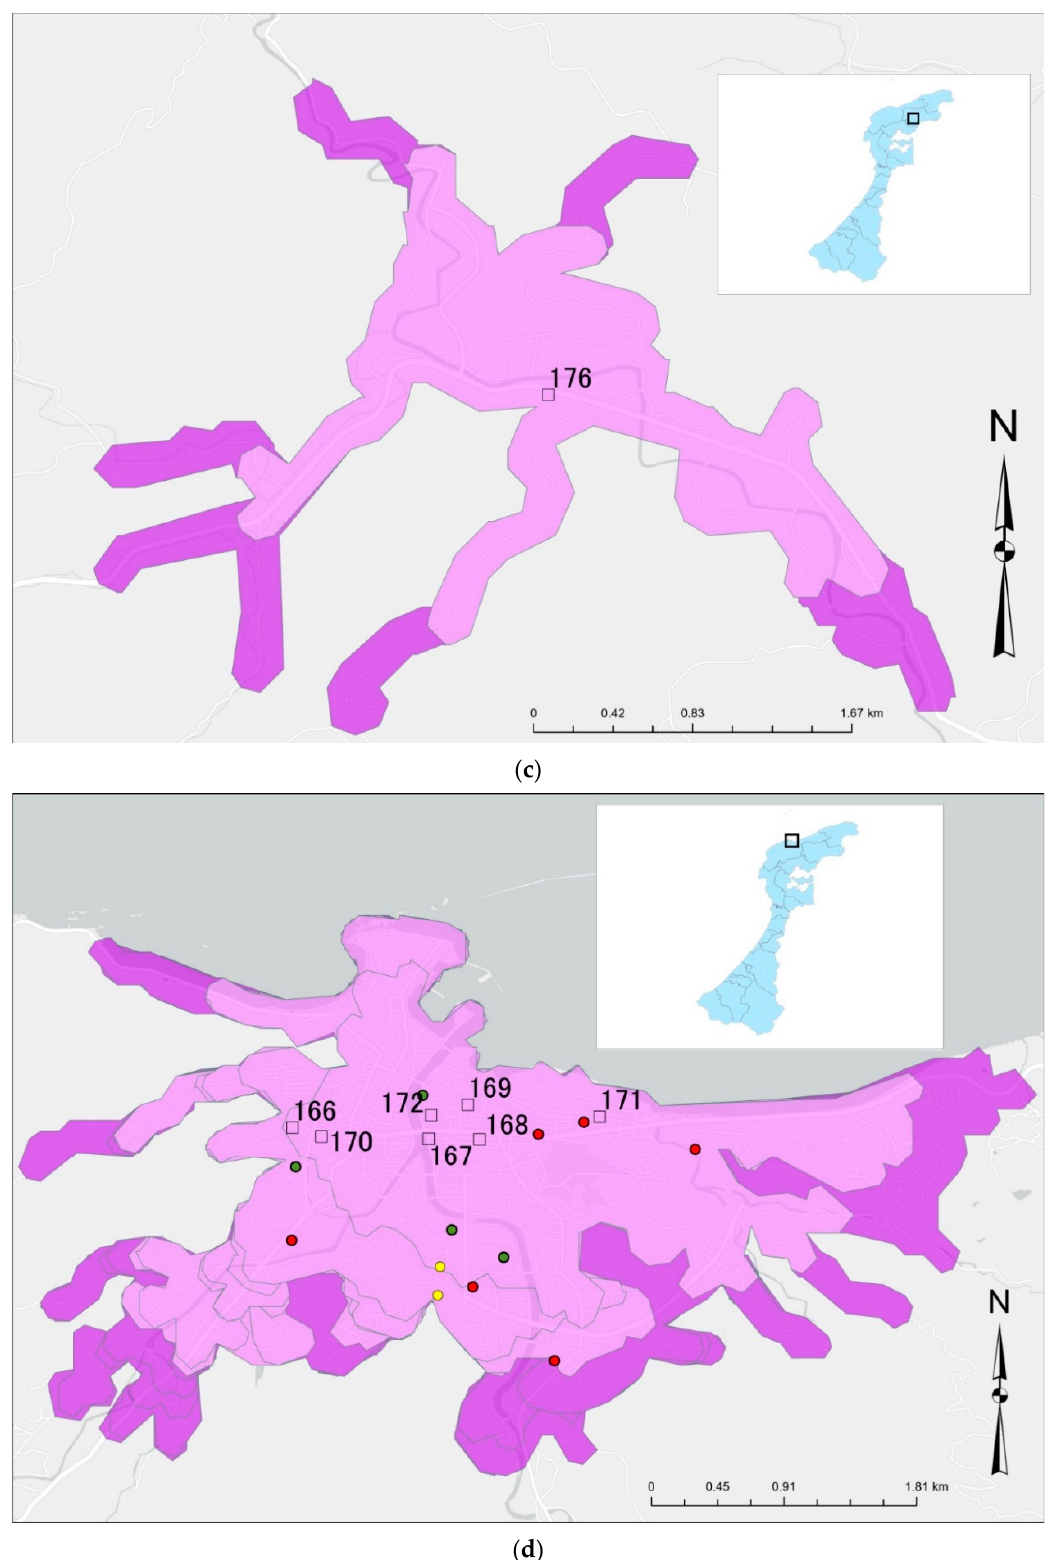
Figure 2. ( a ) Geographical distribution of GHs and SPs in ELAs in Suzu City and Noto Town. ( b ) Geographical distribution of GHs and SPs in ELAs in Noto Town (For legends, see Figure 2a). ( c ) Geographical distribution of GHs and SPs in ELAs in Noto Town (For legends, see Figure 2a). ( d ) Geographical distribution of GHs and SPs in ELAs in Wajima City (For legends, see Figure 2a).